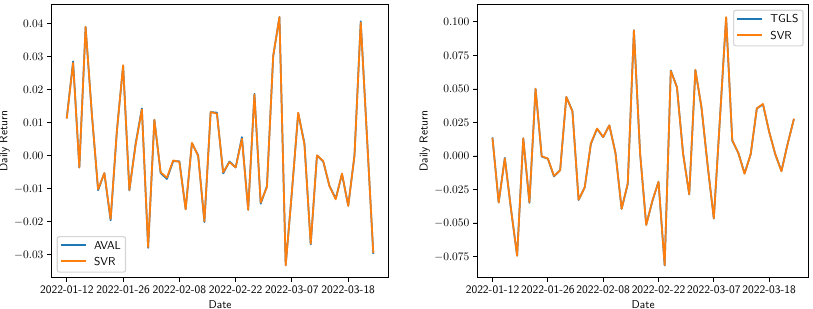
Figure 5. Real vs. SVR adjustment for the daily returns of Bancolombia, Ecopetrol, Grupo AVAL, and Tecnoglass. The real time series is represented by the share symbol and its prediction with the model name in the legend.